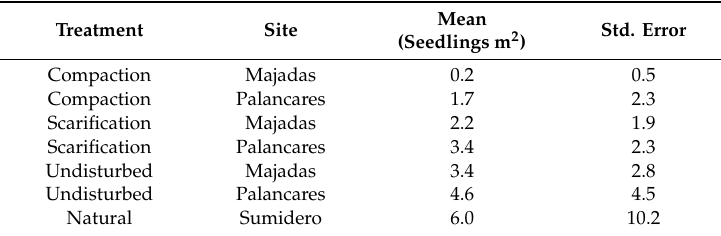
Table 2. Mean and standard error of the number of recruits (response) for the studied treatments (factors) in Spanish black pine forests (Cuenca Mountains, Spain).